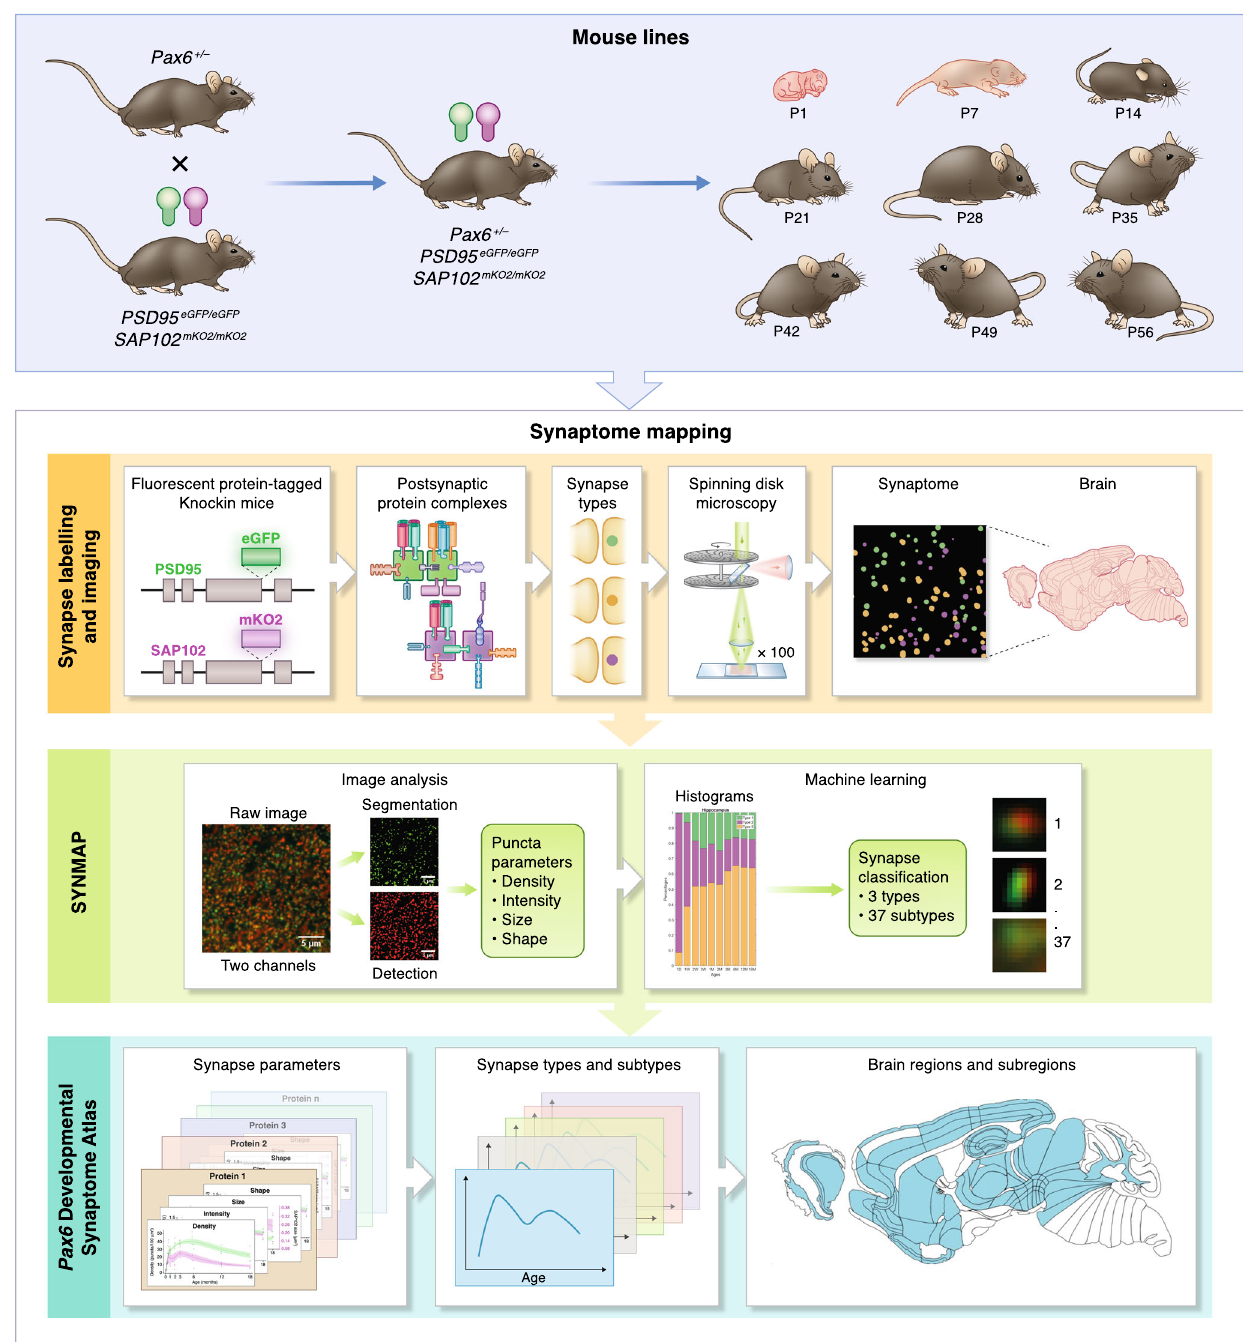
Fig.1|Procedureformappingthesynaptomearchitectureof Pax6 +/ − mice. Mice carrying the heterozygous Pax6 mutation were crossed with mice carrying fl uores- cently tagged PSD95 and SAP102 proteins to produce cohorts of Pax6 +/ − ; Psd9 5 eGFP/eGFP ; - Sap102 mKO2/mKO2 and control Pax6 +/+ ;Psd95 eGFP/eGFP ; Sap102 mKO2/mKO2 mice. Genetic tagging of the endogenous Psd95 and Sap102 loci with eGFP and mKO2 results in the expression of PSD95-eGFP and SAP102-mKO2 fl uorescent fusion proteins, which assemble into postsynaptic protein complexes. The differential distribution of these proteinsintosynapsesunderliessynapsetypediversity,whichcanbevisualizedinbrain